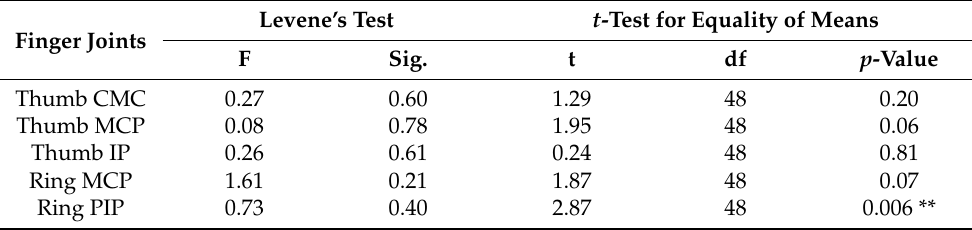
Table 6. Independent samples t-test for comparison flexion angles with respect to Test 11 and Test 15.